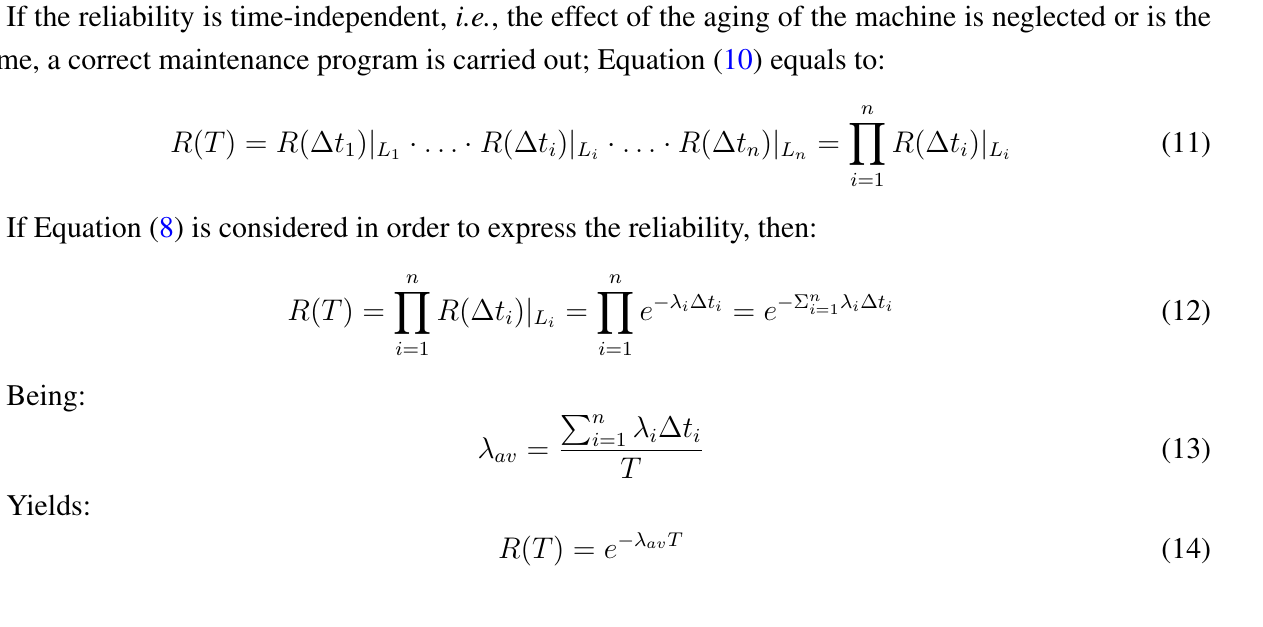
Figure 5. Plot of µ ( Q/Q